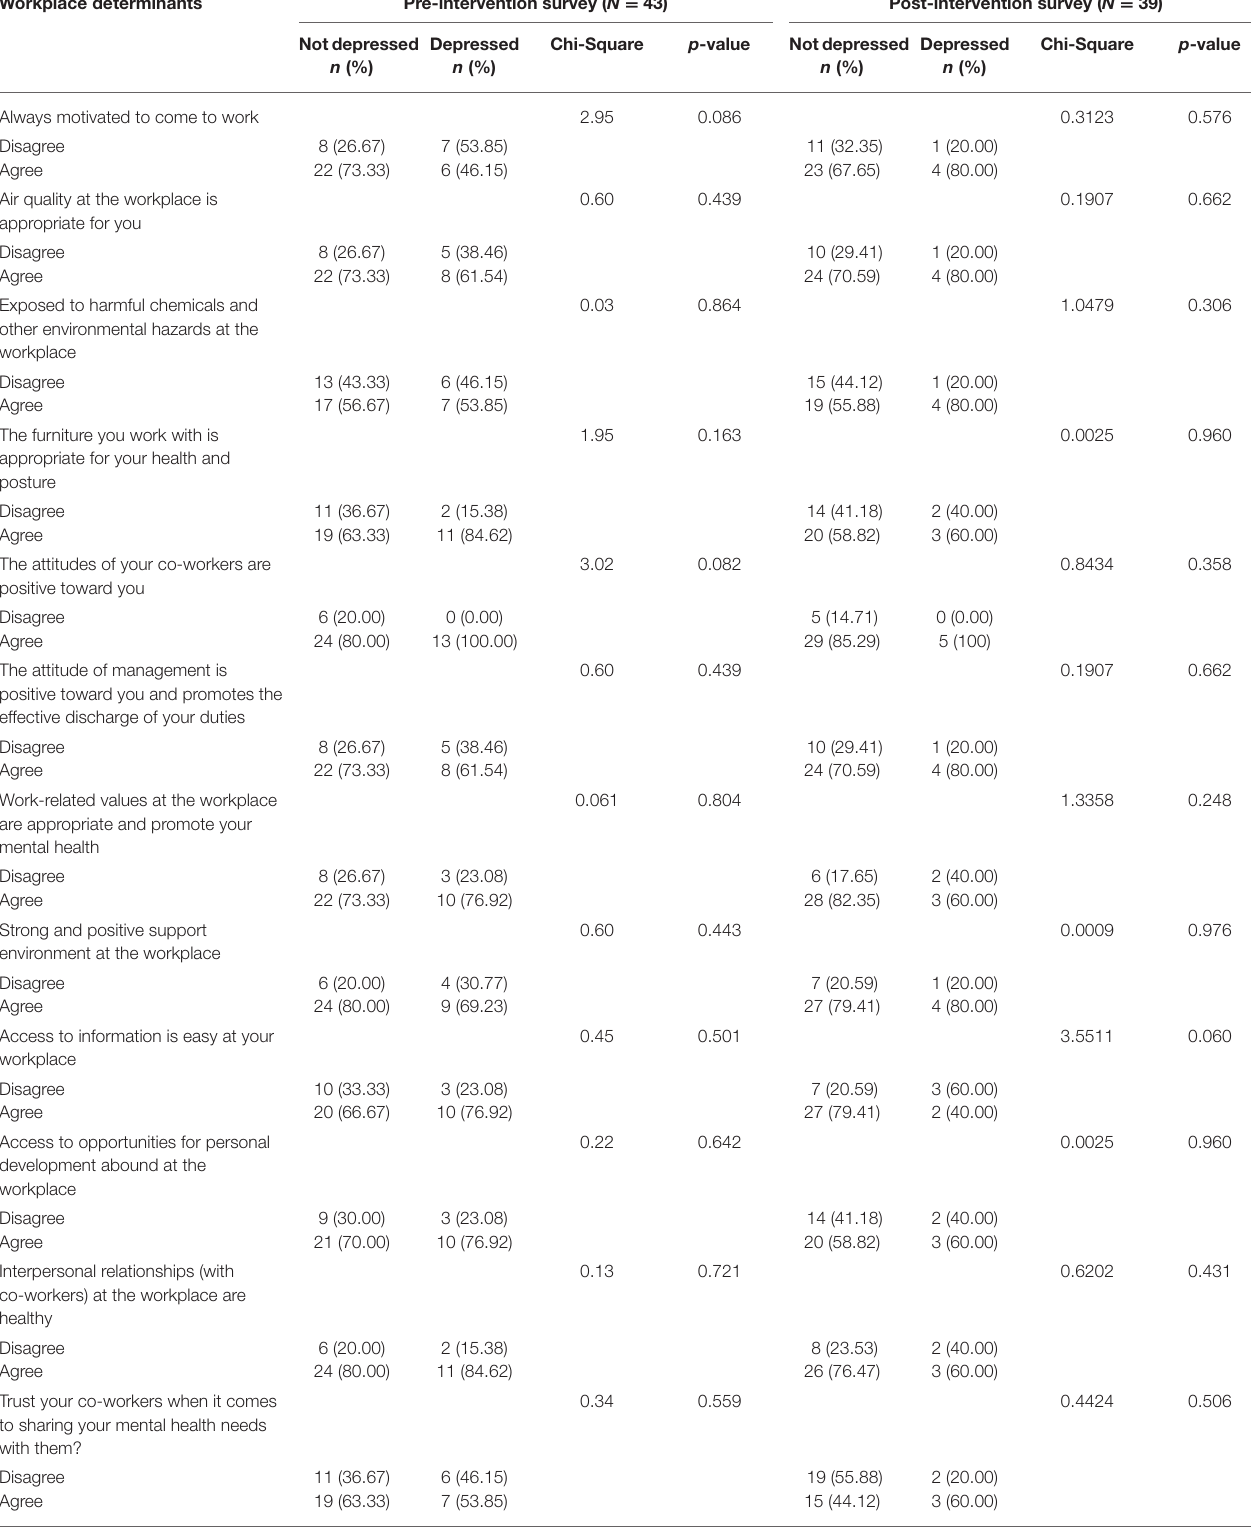
TABLE 3 | Bivariable relationship between workplace determinants and depression. Workplace determinants Pre-intervention survey ( N = 43) Post-intervention survey ( N = 39)